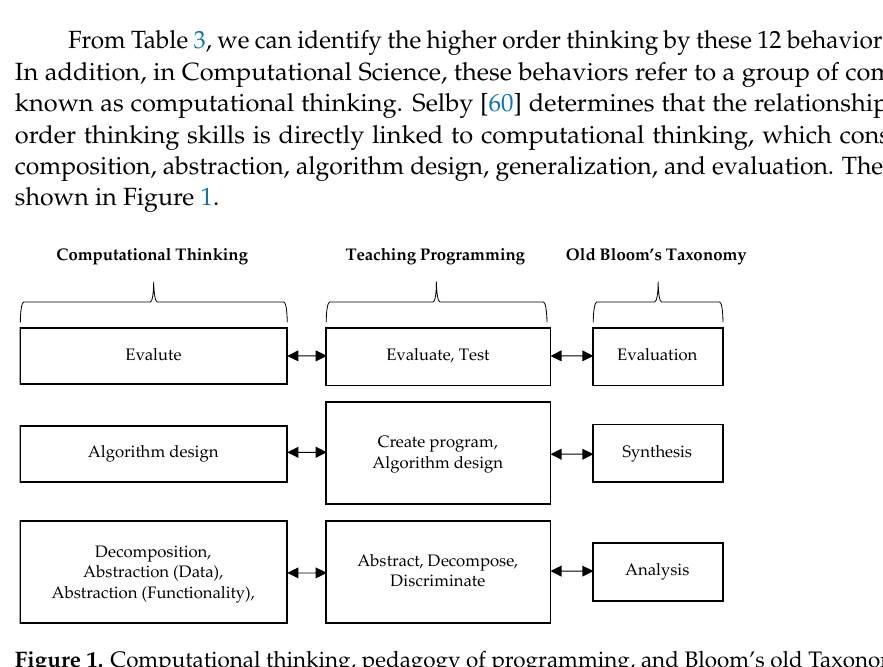
Figure 1. Computational thinking, pedagogy of programming, and Bloom’s old Taxonomy